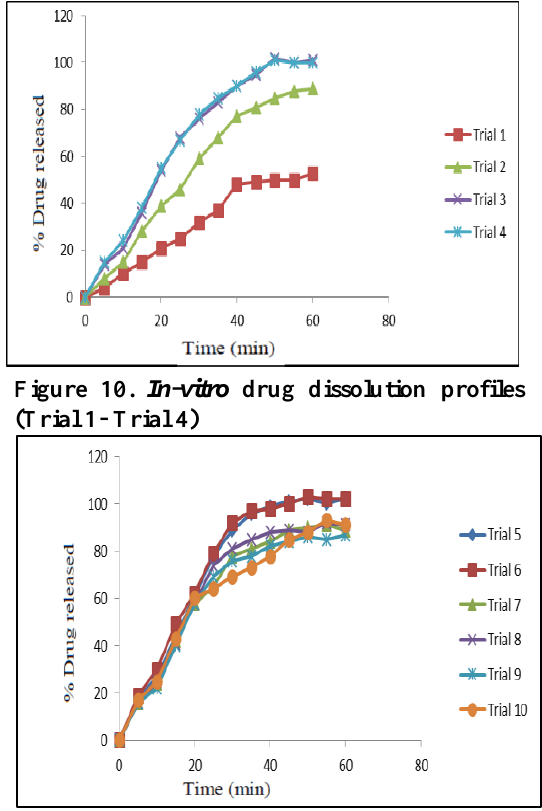
Figure11. In-vitro drug dissolution profiles (Trial 5- Trial